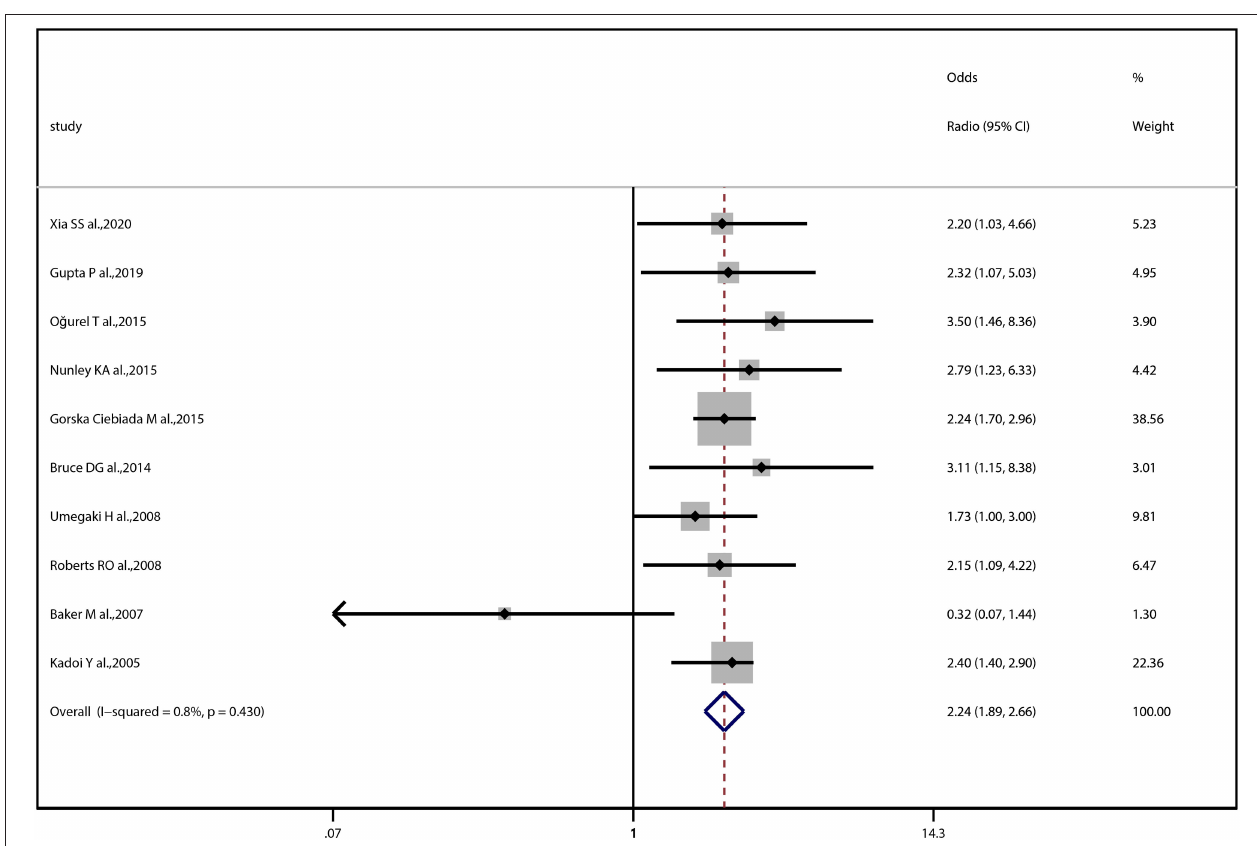
FIGURE 2 | Forest plot and pooled estimates of the association between diabetic retinopathy and cognitive impairment. Each study corresponds to a horizontal line and a square. The size of the square represents the weight of the study in the pooled analysis, and the length of the horizontal line represents the 95% confidence interval (CI). The pooled fixed-effect estimate and its 95% CI are represented by a dashed vertical and a diamond. The vertical at 1 indicates that diabetic retinopathy is not associated with cognitive impairment.